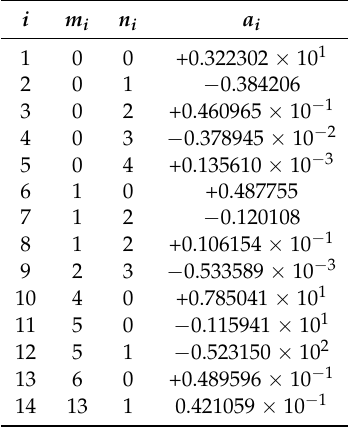
Table 1. Coefficients for Equation (13).